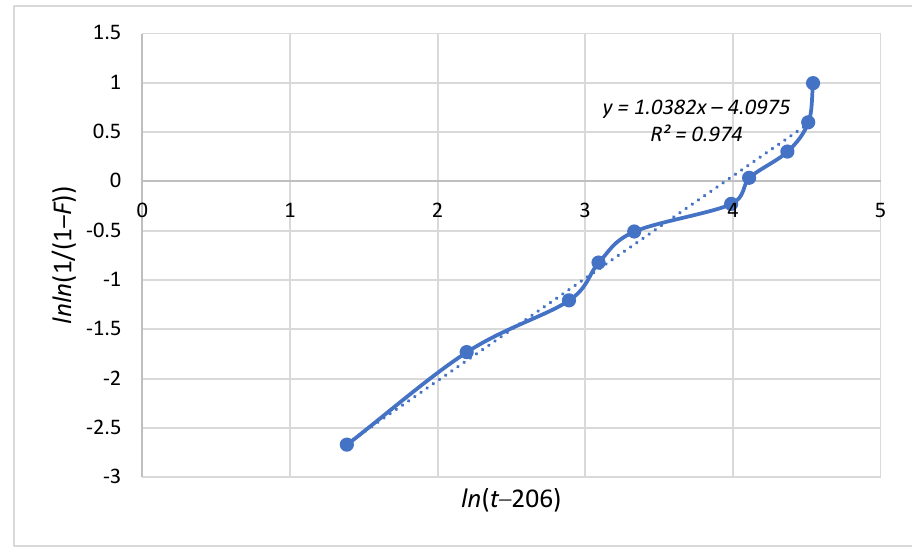
Figure 6. Weibull three-parametric graph for γ optimum = 206 h and regression line.